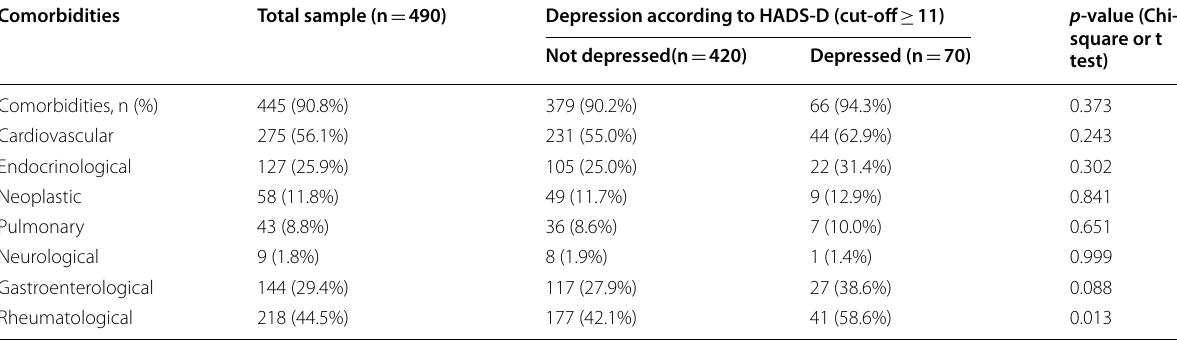
RF rheumatoid factor; ACPA anti-citrullinated protein antibodies; BMI Body Mass Index, TJC tender joint count; SJC swollen joint count; PhGA physician global assessment; PGA patient global assessment; VAS visual analogue scale; ESR erythrocyte sedimentation rate; CRP C-reactive protein Table 3 Presence of comorbidities and their association with depression (n Comorbidities Total sample (n